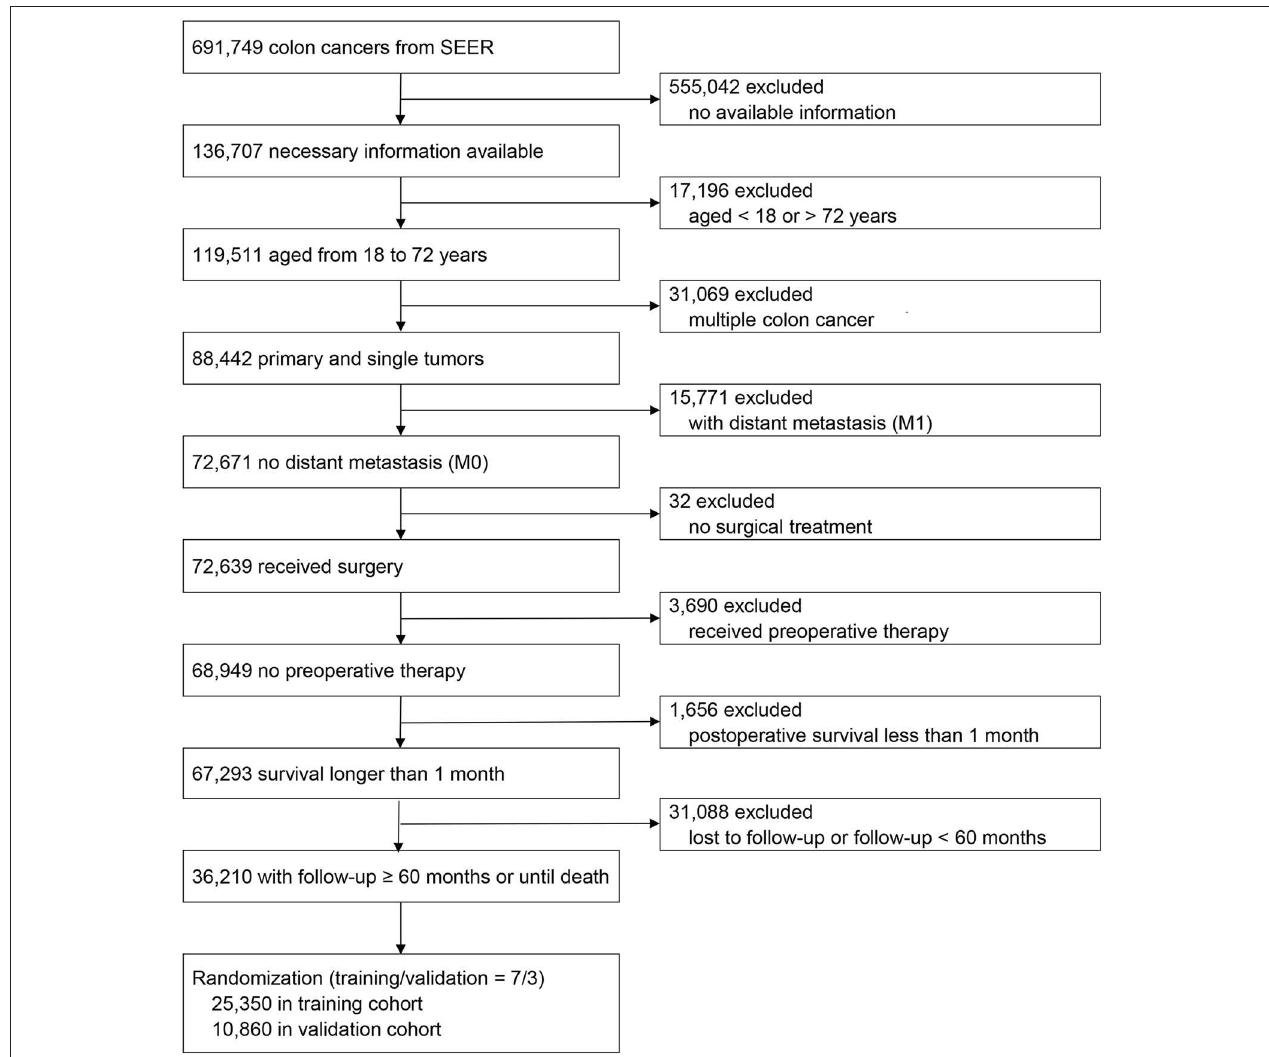
FIGURE 1 | Flow chart for patient selection and study